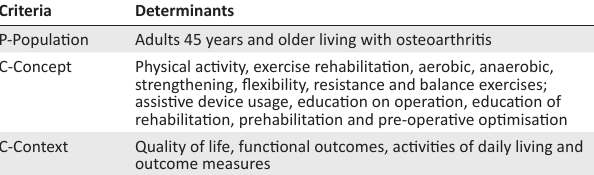
TABLE 1: Population concept context framework for eligibility of